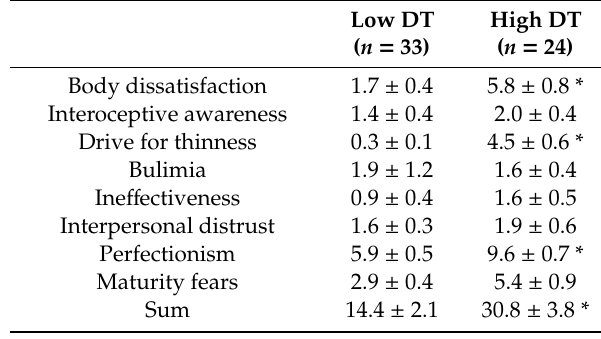
Table 1. Eating Disorder Inventory (EDI) scores of the women with a low drive for thinness and high drive for